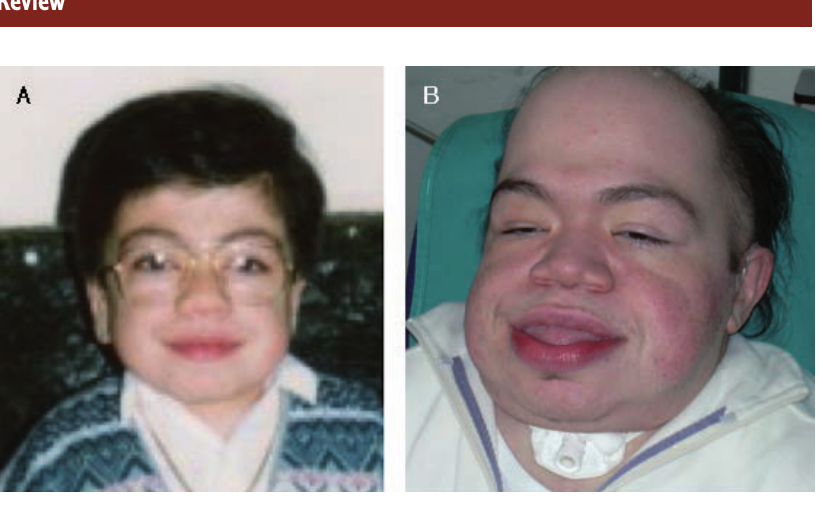
Figure 5. Tracheal stenosis in mucopolysac- charidosis type II patient (multidetector computed tomography).